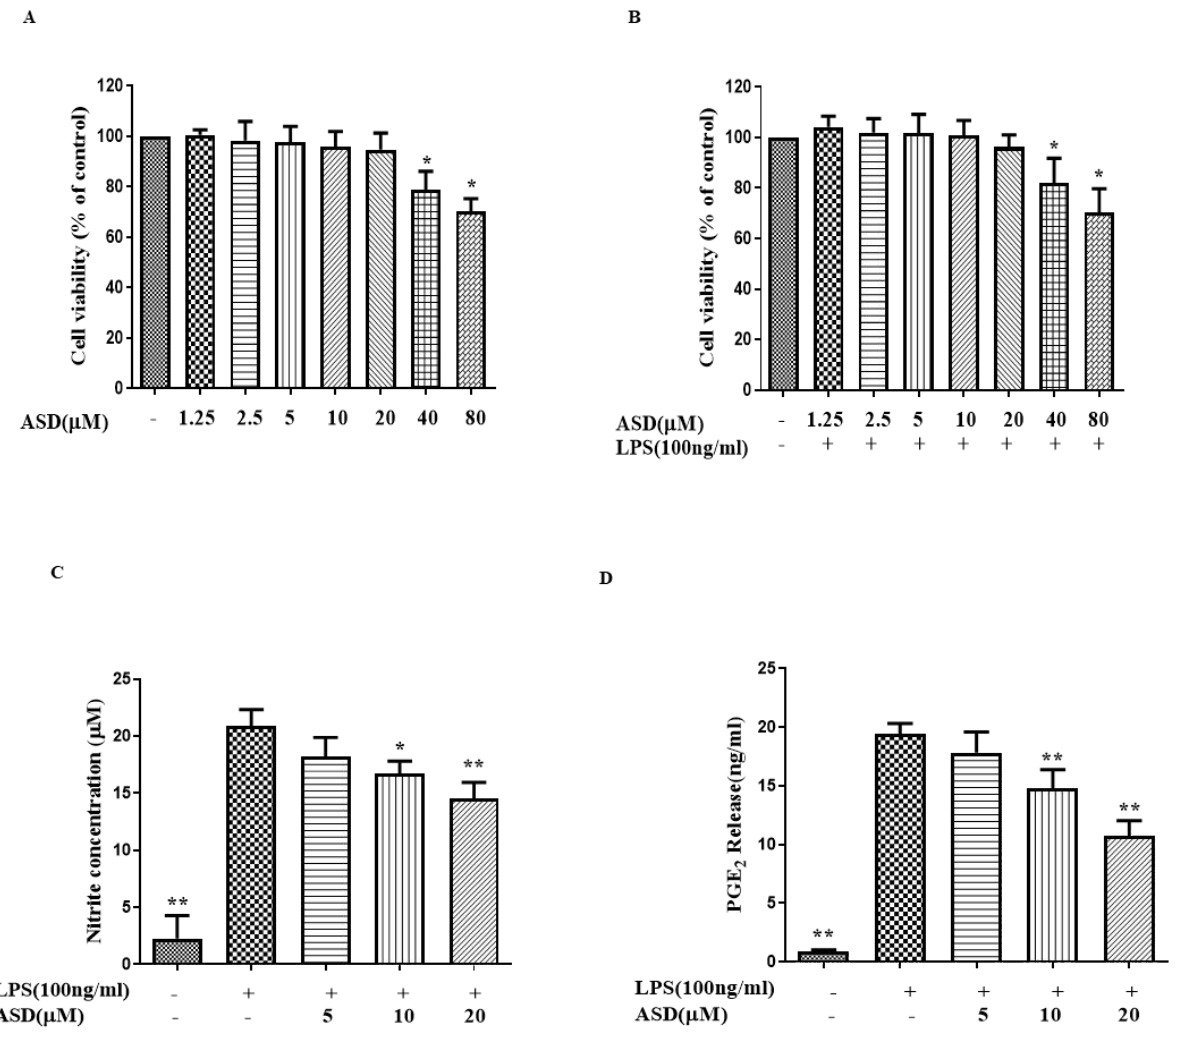
Figure 1. The pharmacological action of ASD on the levels of NO and PGE 2 . ( A ) Effect of ASD toxicity on the cell viability (without LPS). ( B ) Effect of ASD toxicity on the cell viability (with LPS). Effects of ASD on the secretion of NO ( C ) and PGE 2 ( D ). * p < 0.05, vs. LPS-stimulated cells ( A , B ). The data are shown as the average value ± SD, * p < 0.05, vs. LPS-treated cells, ** p < 0.01, vs. LPS-treated cells ( C , D ).